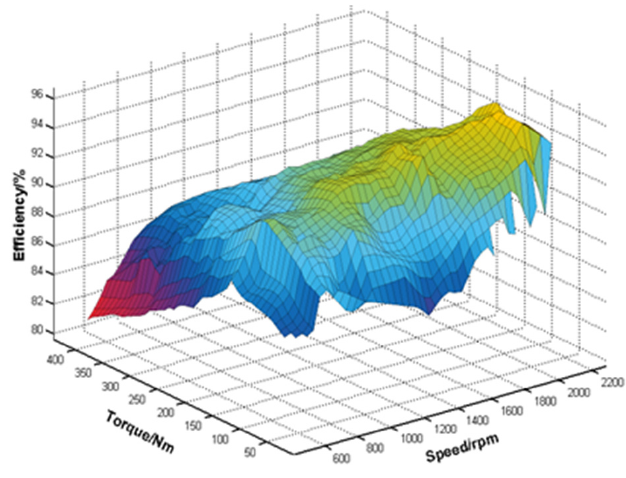
Figure 7. Charging efficiency of battery.